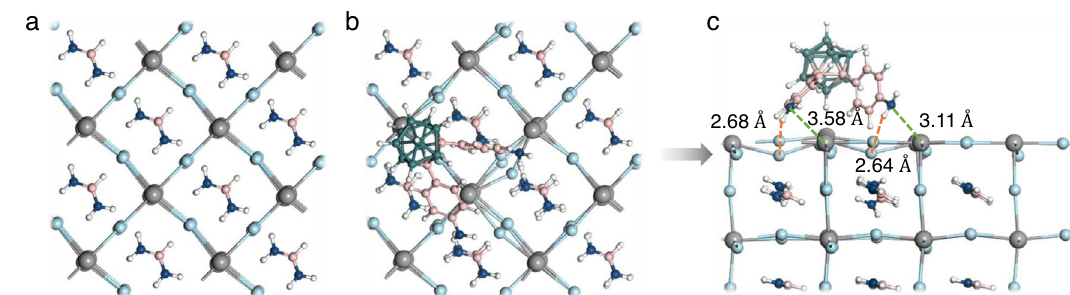
Fig. 7|Interactionbetween CB-NH 2 and perovskitefromDFTcalculations. Top views of PbI 2 -terminated perovskite surface a without and b with CB-NH 2 . c Side views of the perovskite surface adsorbed with CB-NH 2 . Notes: the length of N-H···I/